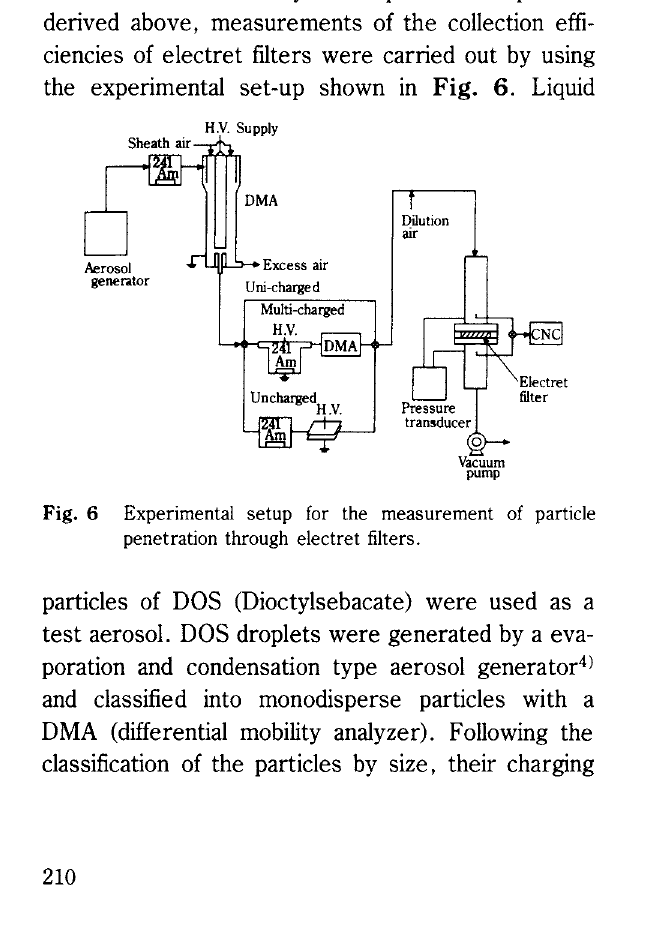
Fig. 7 Effect of particle and fiber charges on particle